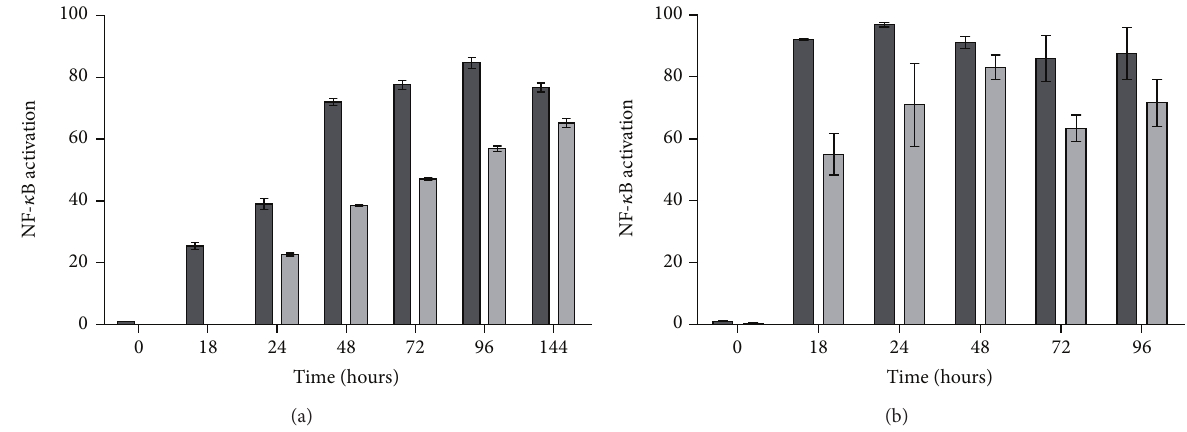
Figure 2: NF- 𝜅 B activation time course kinetics for different clones. Caco-2-NF- 𝜅 B-hrGFP C3 (black bar) and D5 (grey bar) clones (a) were seeded at 1 × 10 5 cell/well, and HT-29-NF- 𝜅 B-hrGFP E5 (black bar) and F6 (grey bar) clones (b) were seeded at 5 × 10 4 cell/well. Cells were cultured ON and treated with 50 ng/mL of TNF- 𝛼 over time. Cells were trypsinized and GFP expression was analyzed at different time points by flow cytometry. Data was expressed as mean of triplicates with SD error bars. NF- 𝜅 B activation was determined by the subtraction of the % GFP + of nonstimulated cells from the % GFP + of stimulated